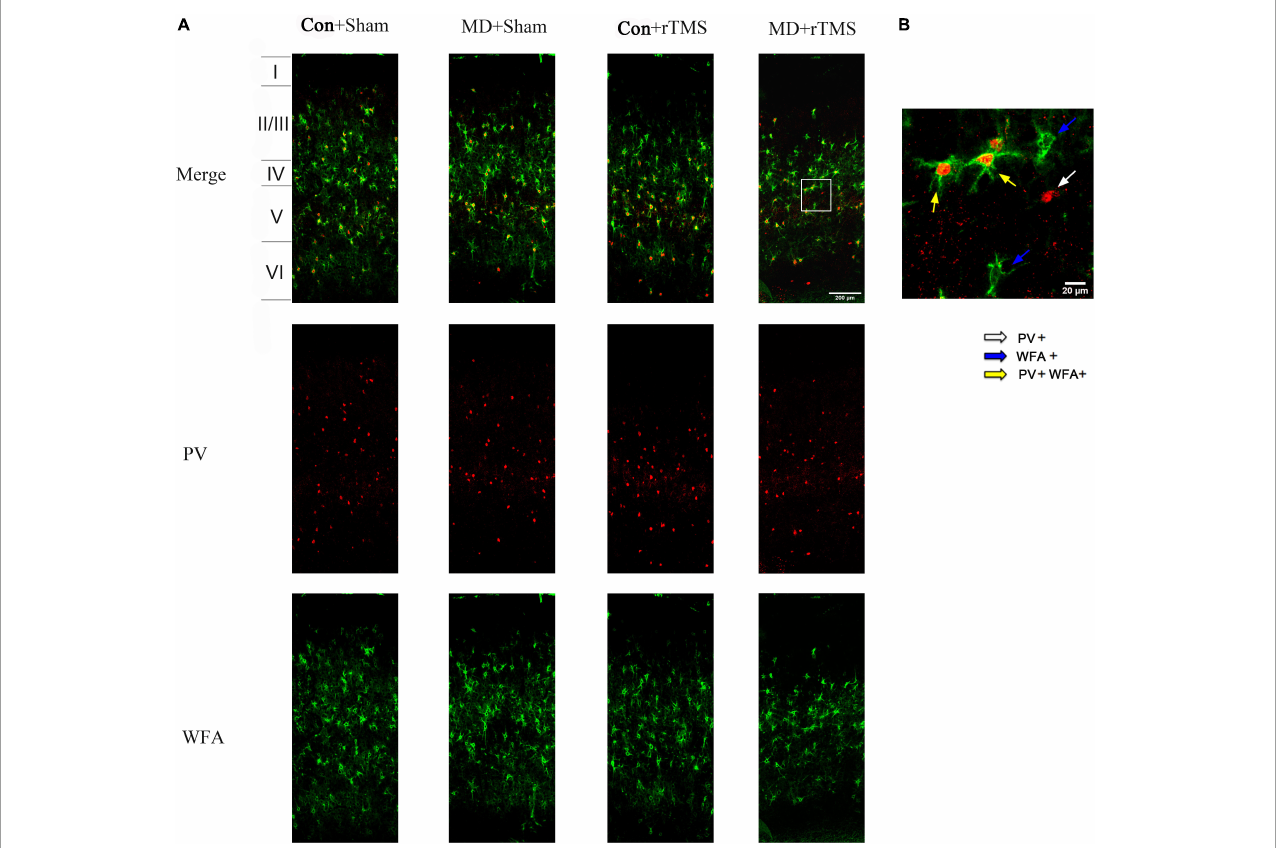
FIGURE6 Expression of parvalbumin (PV) and wisteria floribunda agglutinin (WFA)-positive cells in the primary visual cortex (V1B) of the rats in each group. (A) Coronal section of V1B in each group. Laminar distribution of PV- and WFA-positive cells are stained with red and green fluorescence, respectively; scale bar: 200 µ m. (B) A high-magnification view of the area selected by the white frame in panel (A) . The white arrow points to PV-positive cells; the blue arrows point to WFA-positive cells; the yellow arrows point to PV/WFA double-labeled cells; scale bar: 20 µ